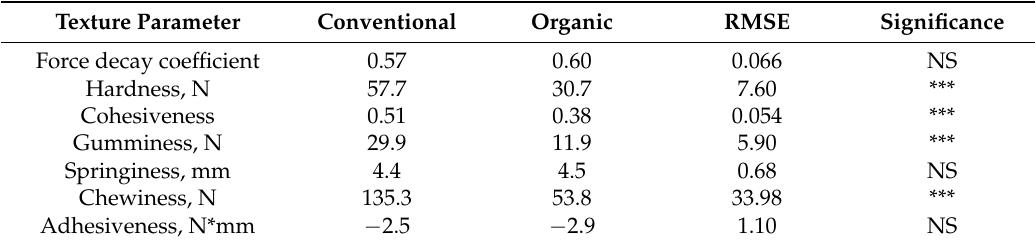
Table 4. Instrumental texture parameters of dry-fermented sausages (six per treatment group) manufactured without nitrite addition from pigs fattened in conventional or organic system.